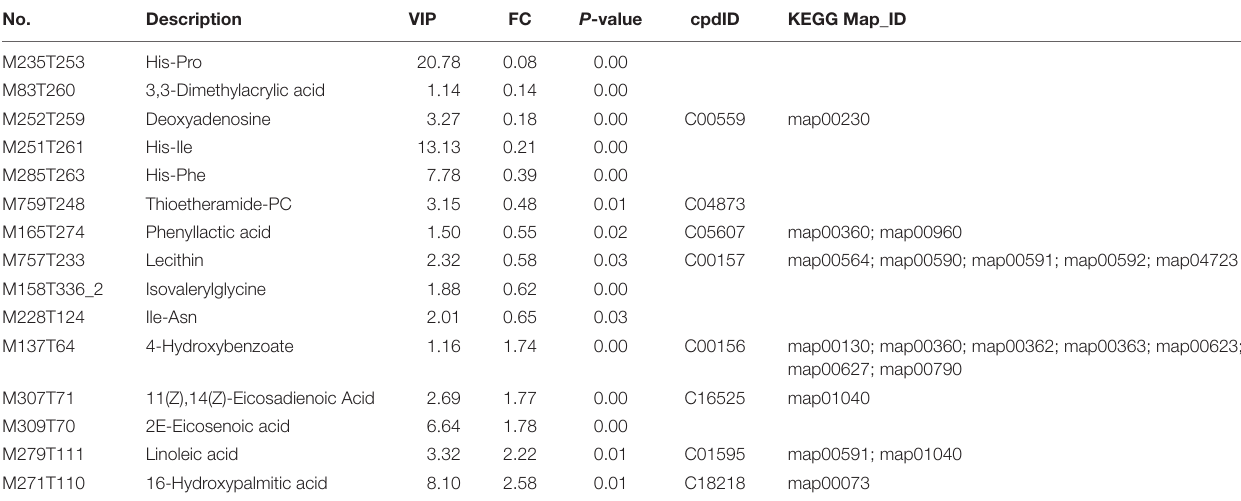
TABLE 1 | Significantly differential metabolites between TPA and